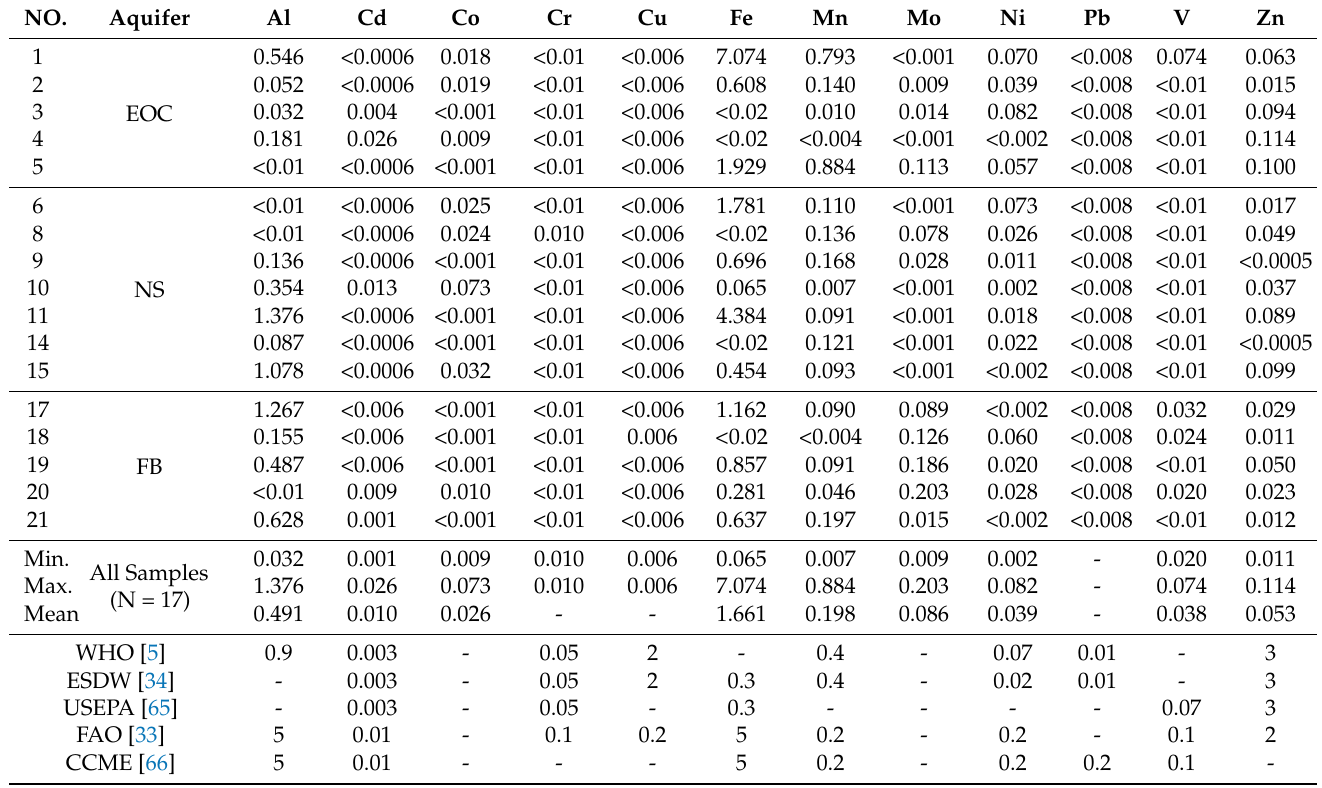
Table 3. Trace element concentrations (mg/L) in EOC, NS, and FB